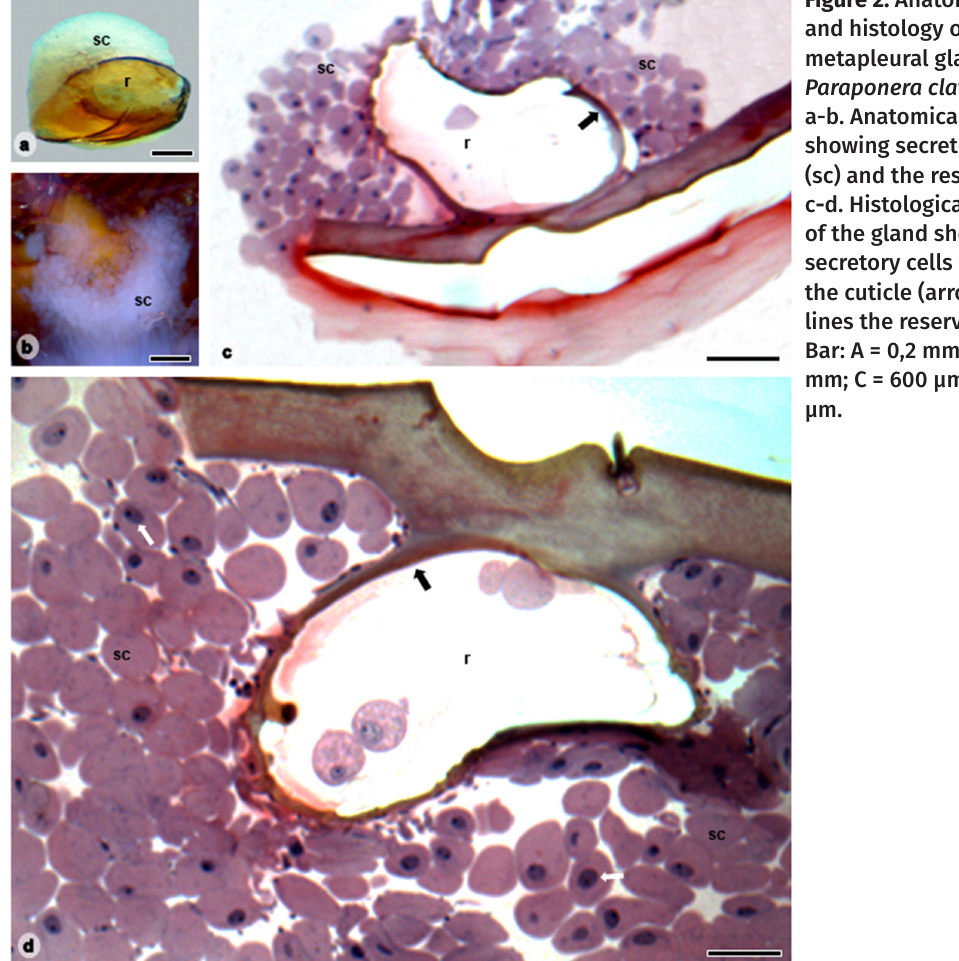
Figure 2. Anatomy and histology of the metapleural gland of Paraponera clavata . a-b. Anatomical view showing secretory cells (sc) and the reservoir (r). c - d. Histological section of the gland showing: secretory cells (sc)